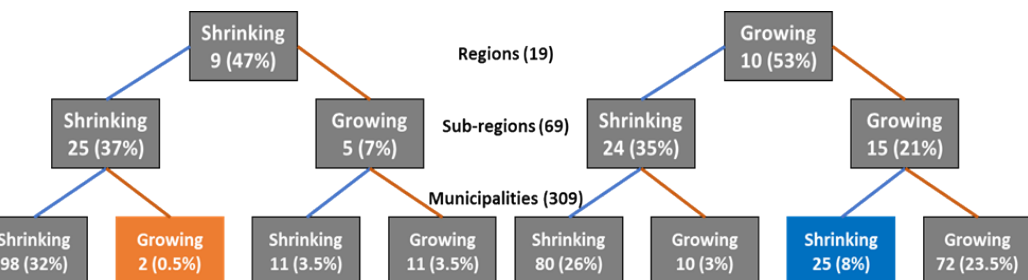
Fig. 5. Number and shares of shrinkage (blue) and growth (orange) pockets in terms of population,